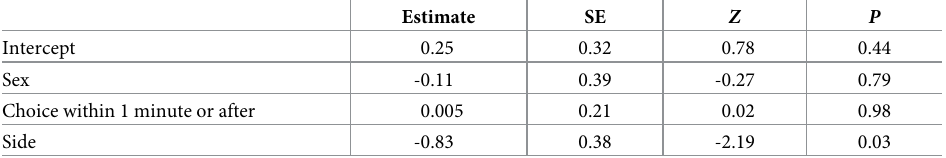
Table 3. Model for bird choice in relation to: The difference in the MHC-I amino acid distance between the focal birds and the two scent donor birds of the opposite sex (as a dichotomous variable: Greater MHC-I amino acid distance (yes) vs. lower MHC-I amino acid distance